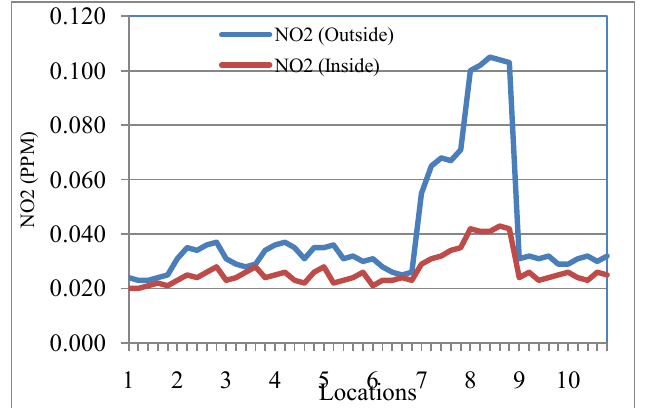
Fig. 5: Monitored NO 2 Concentrations Inside and Outside of Houses 10 Locations in the Study Area